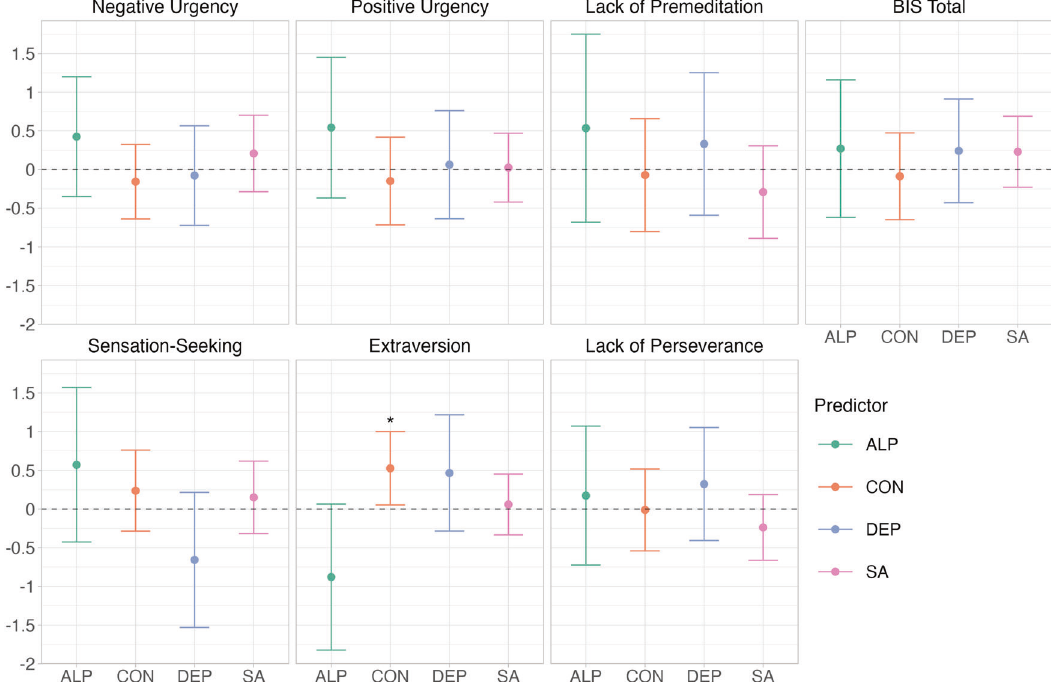
Fig. 3 Standardized conditional associations of alcohol consumption, problems, and dependence and suicide attempt with impulsive personality traits. Each impulsive personality trait was considered in a separate model. represent 95% con fi dence intervals. Statistically signi fi cant parameter estimates are annotated with an